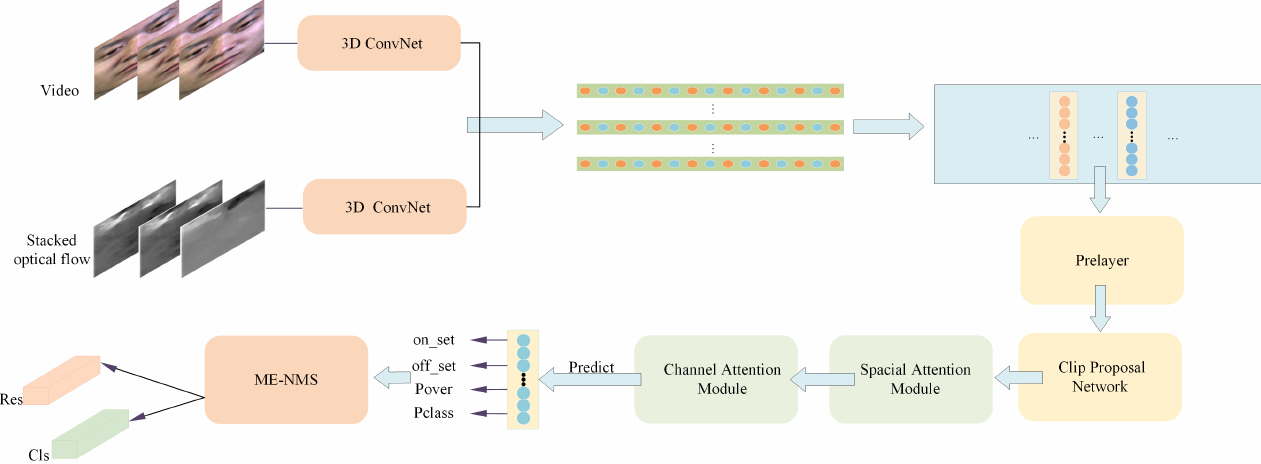
Figure 2. Backbone network: AEM-net consists of four parts, which are the multi-stage channel fea- ture extraction module (Prelayer, introduced in Section 3.1.1); the multi-scale fused-feature localization network (clip proposal network, elaborated in Section 3.2.1); the position suppression and adaptive deep feature enhancement module (spatial attention block, elaborated in Section 3.2.2; channel attention module, explained in Section 3.2.2) and the ME-NMS module (described in Algorithm 1). Given a video with MaEs or MEs or both, AEM-Net aims to locate all the MaE and ME (cid:110) (cid:111) f ( i ) on , f ( i ) of f , c ( i ) instances appropriately. Suppose that all expressions M ( i ) = in this video, where f ( i ) on and f ( i ) of f represent onset and offset frames of the i th expression, respectively; c ( i ) indicates the category